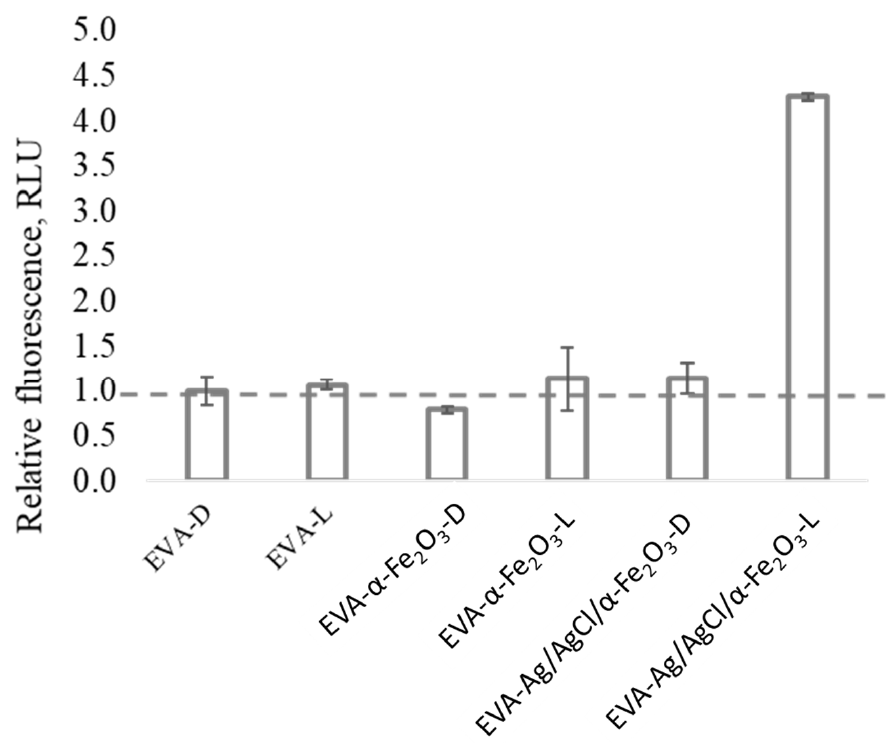
Figure 6. Generation of reactive oxygen species (ROS) measured with fluorescent dye DCF-DA in abiotic conditions (i.e., without the bacterial cells). Relative fluorescence units (RFUs) due to ROS production in the liquid in contact with EVA-coating, EVA-hematite coating, and EVA-Ag/AgCl/α- Fe 2 O 3 composite coating in the dark [D], and upon visible-light illumination [L].